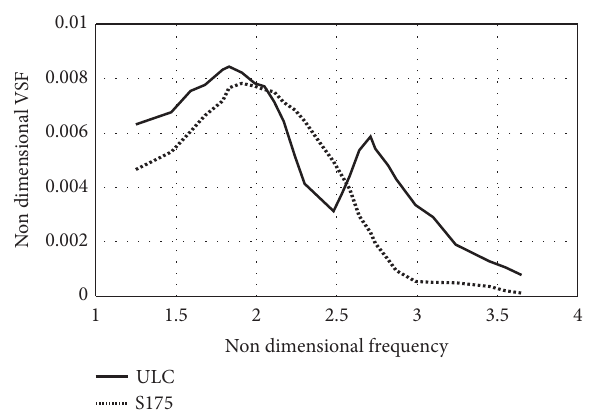
Figure 15: Shear force RAO comparison between S175 and the ULC ( F